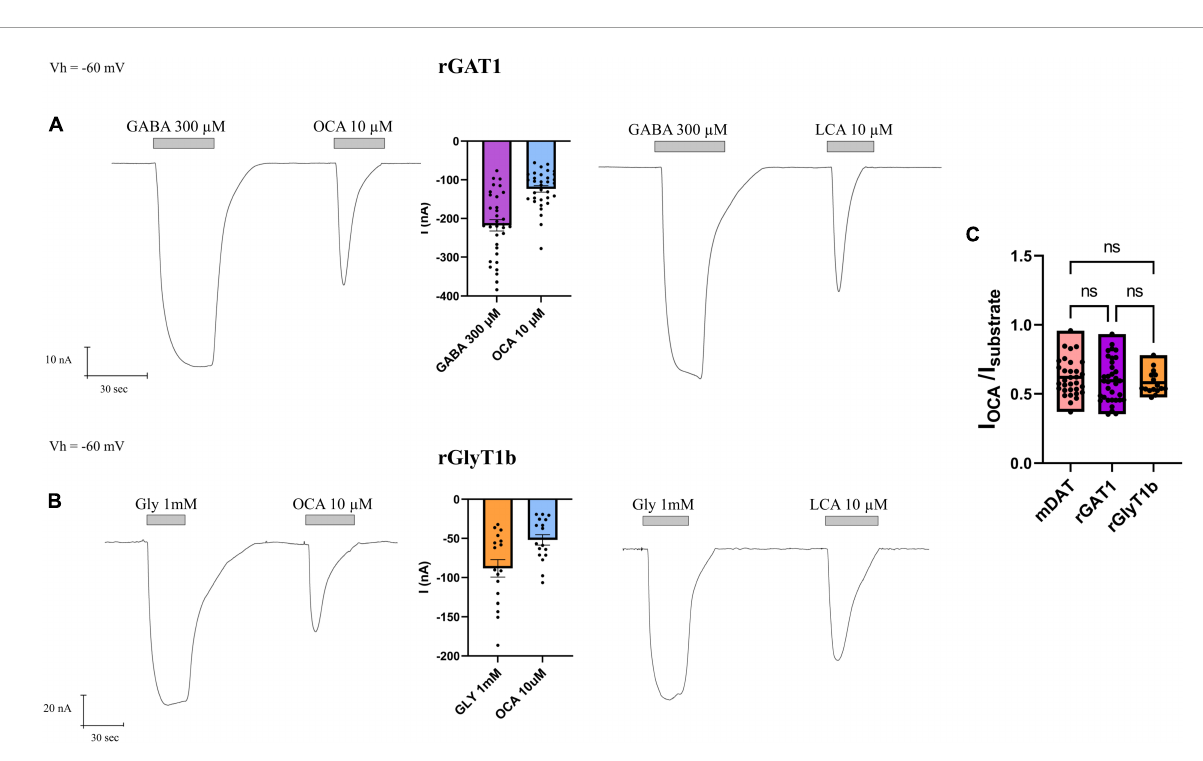
FIGURE4 Obeticholic acid (OCA) effect on neurotransmitter transporters GAT1 (SLC6A1) and GlyT1b (SLC6A9). (A) Representative traces recorded by TEVC from oocytes expressing rGAT1 exposed to GABA and OCA (left) or GABA and LCA (right); mean of currents (center) (nA) ± SE of 33/6 n/N. (B) Representative traces recorded by TEVC from oocytes expressing rGlyT1b exposed to glycine and OCA (left) or glycine and LCA (right); mean of currents (center) (nA) ± SE of 17/4 n/N. (C) mean of normalized OCA current for rGlyT1b, mDAT, and rGAT1; (nA) ± SE of 16–34/6 n/N; one-way ANOVA F ( 2 , 79 ) = 0.4982, p = 0.6094 followed by Bonferroni’s multiple comparison test. I OCA /I DA vs. I OCA /I GABA : p > 0.9999; I OCA /I DA vs. I OCA /I Gly : p > 0.9999; I OCA /I Gly vs. I OCA /I GABA : p >